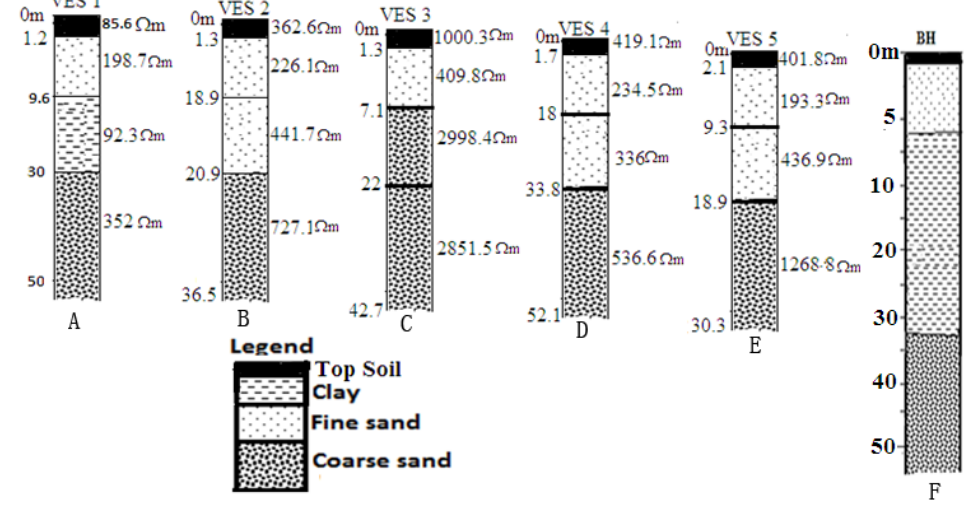
Figure 8. ( A – E ) Lithologies inferred from interpretation of VES 1–5 and ( F ) borehole log located along profile